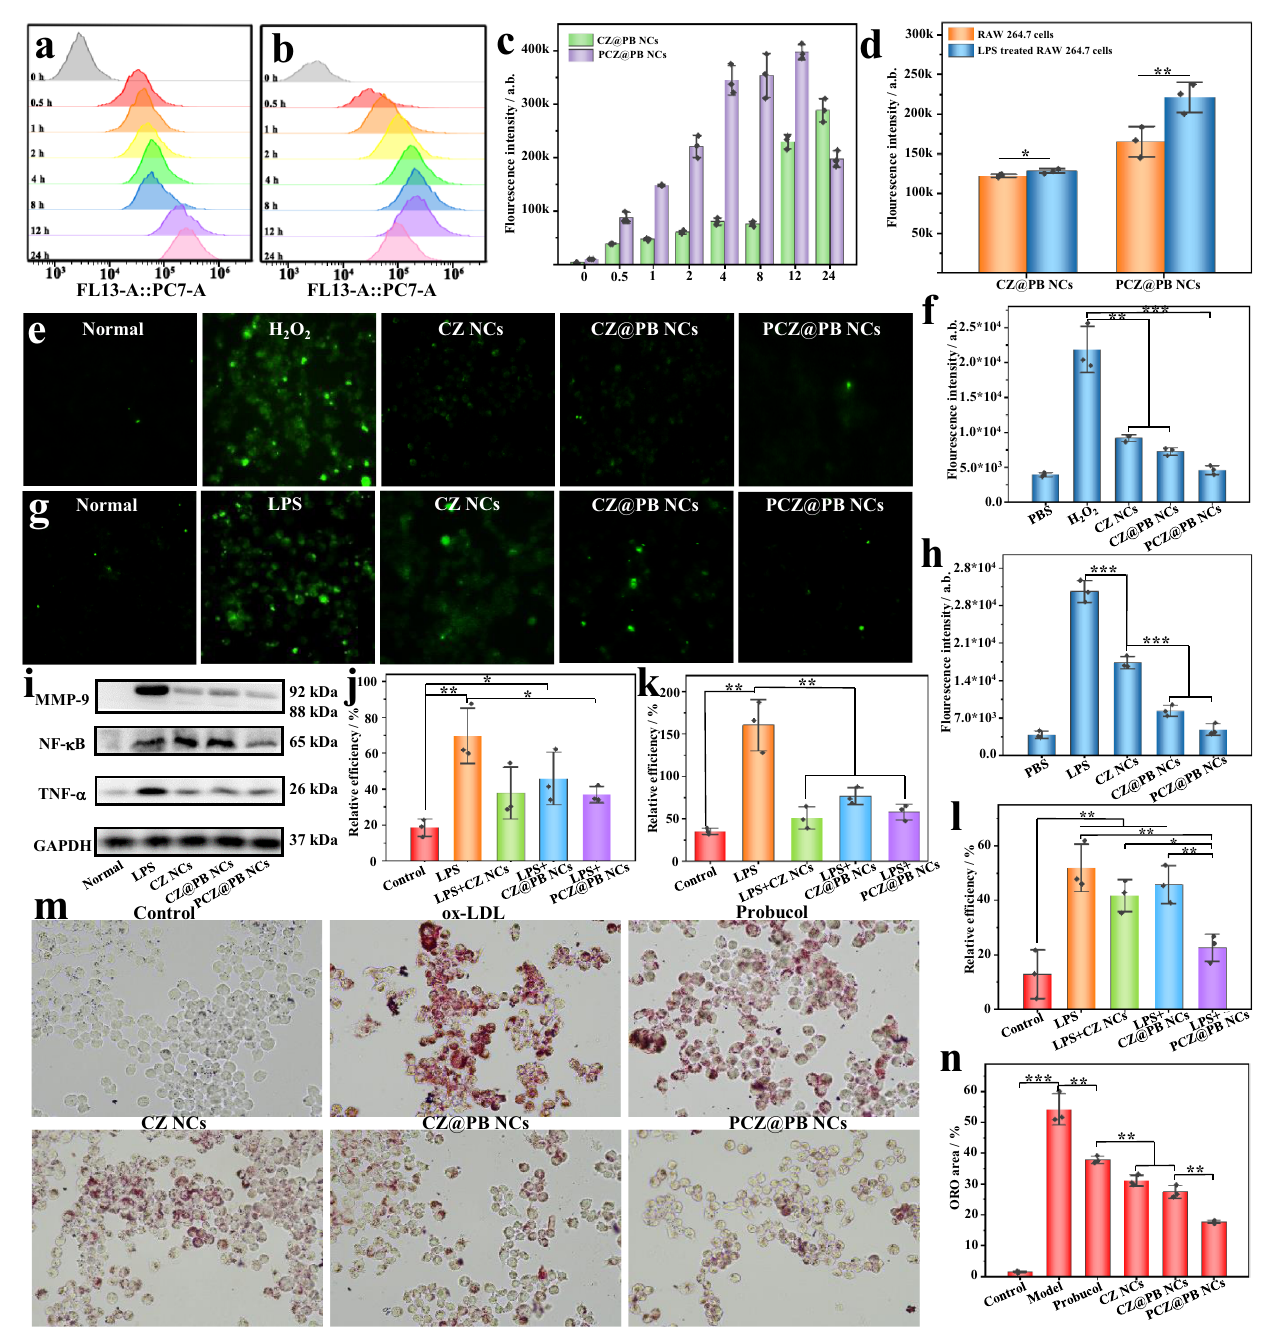
Fig. 4 | In vitro effects of the biomimetic nanodrug PCZ@PB NCs. a Uptake of CZ@PBNCsand b PCZ@PBNCsbyRAW264.7cellswithin24h. c Quanti fi cationof uptakebasedon fl uorescenceintensity. d UptakeofCZ@PBNCsandPCZ@PBNCs in RAW 264.7 cells and in fl ammatory RAW 264.7 cells. Intracellular hydrigen per- oxide (H 2 O 2 ) levels were characterized using the DCFH-DA probe. e Cellular fl uorescence imaging. f Fluorescence intensity quanti fi ed using fl ow cytometry. Intracellularreactiveoxygen speciesgeneration following treatmentwith different formulations and stimulation with Lipopolysaccharide (LPS). g Cellular fl uores- cence imaging. h Graph of the fl uorescence intensity quanti fi ed using fl ow cyto- metry. i – l Western blot analysis of the intracellular expression levels